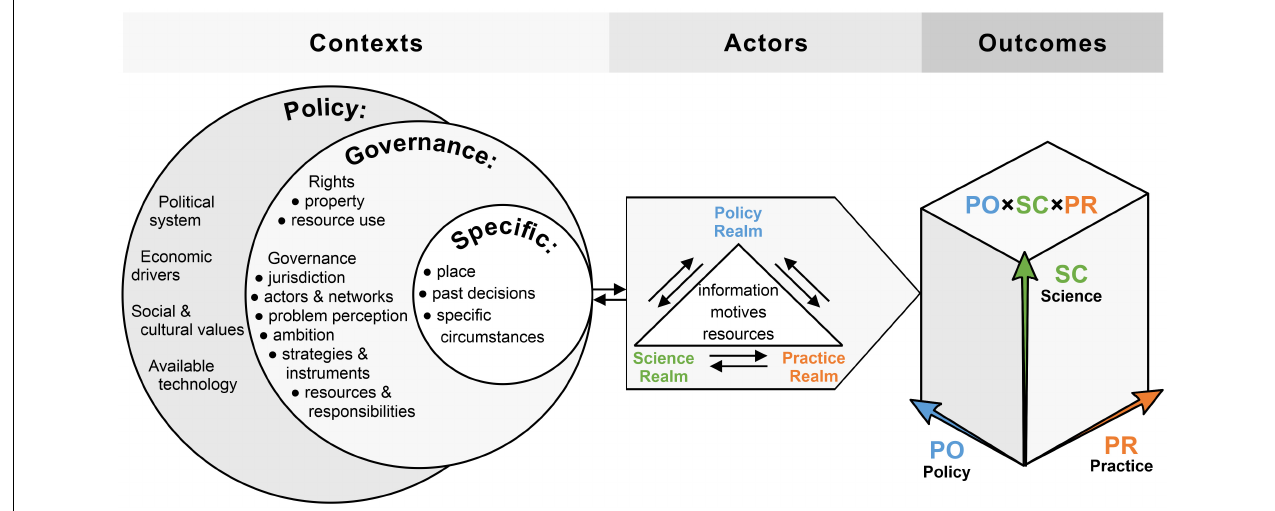
FIGURE 1 | The multiple contexts that influence the decisions and actions of wetland restoration actors and the interaction of knowledge and action among the policy, science, and practice realms in the production of wetland restoration outcomes (modified after Bressers, 2009). A positive wetland restoration outcome is contingent upon the strength of actions and decisions within each of the science, policy, and practice